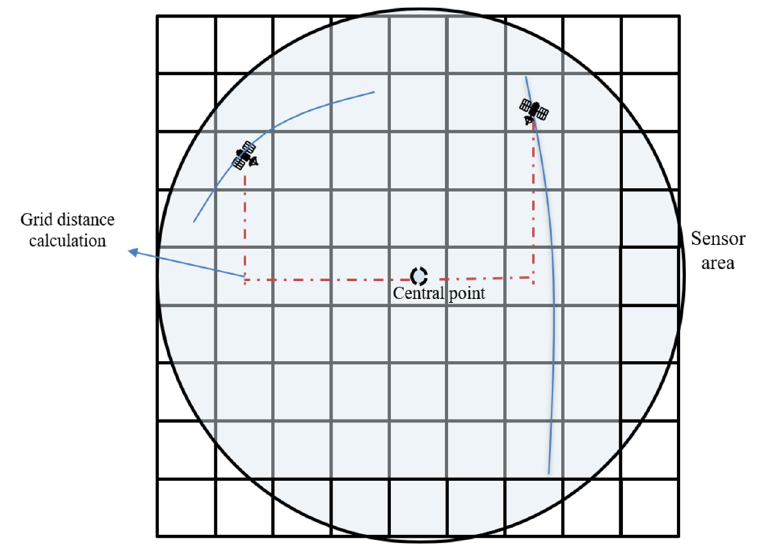
Figure 5. Schematic diagram of 2D grid calculation.